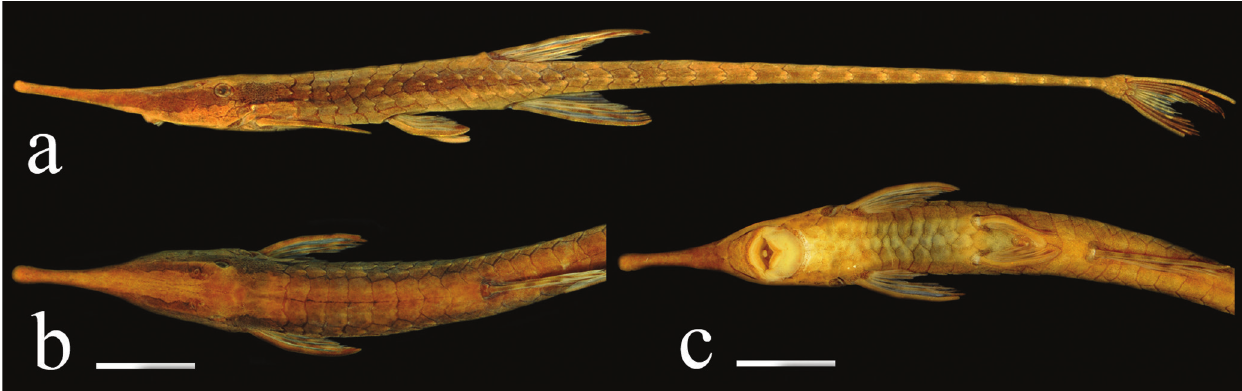
Fig. 2. Farlowella gianetii , Brazil: Mato Grosso, Campinápolis, rio Couto do Magalhães. MZUSP 95564 holotype, 115.6 mm SL, a) lateral, b) dorsal, and c) ventral views. Scale bar: 1